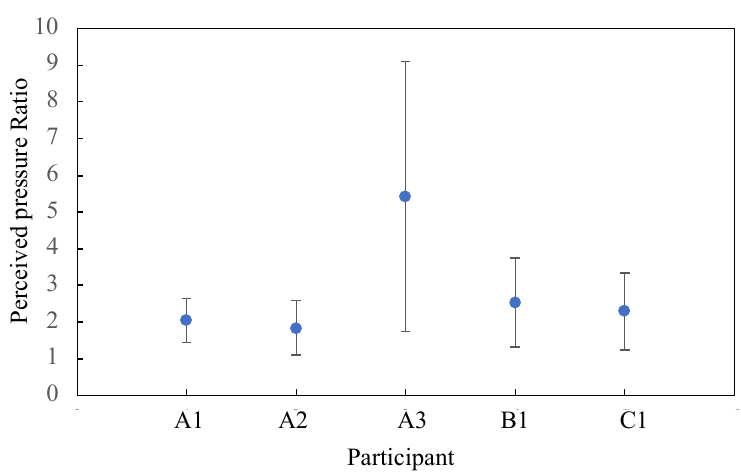
Figure 15. The average and standard deviation of the perceived pressure ratio.